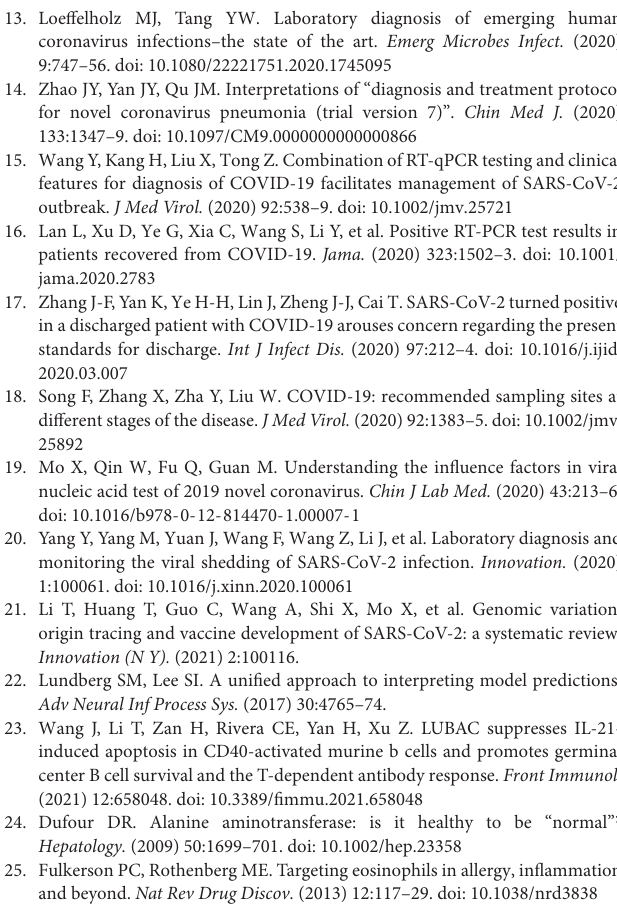
Supplementary Figure 1 | Violin plot of the three statistically significant different biochemical indices between domestic and imported COVID-19 patients. LYM_N, TT, and FIB on the Y-axis represent absolute monocyte, prothrombin time, and fibrinogen, respectively. Imp_Mild, Imp_Moderate, Ind_Mild, and Ind_Moderate on the X-axis represent imported mild-type COVID-19 patients group, imported moderate-type COVID-19 patients group, domestic mild-type COVID-19 patients group, and domestic moderate-type group, respectively. ns P > 0.05, ∗∗ P < 0.01, ∗∗∗ P < 0.001 (Student’s t -test). Supplementary Figure 2 | Comparison of six biochemical indices among the healthy, mild COVID-19, and moderate COVID-19 groups. EOS, absolute eosinophils count; EO, percentage of eosinophils; BASO, absolute basophil count; TP, total proteins; HGB, hemoglobin concentration; NEU_P, neutrophil count percentage; Mild_Covid-19, mild-type COVID-19; Moderate_Covid-19, moderate-type COVID-19. ns P > 0.05, ∗ P < 0.05, ∗∗ P < 0.01, ∗∗∗ P < 0.001 (Student’s t -test). Supplementary Table 1 | Clinical symptoms of patients with COVID-19. Supplementary Table 2 | Clinical treatment of COVID-19 patients.